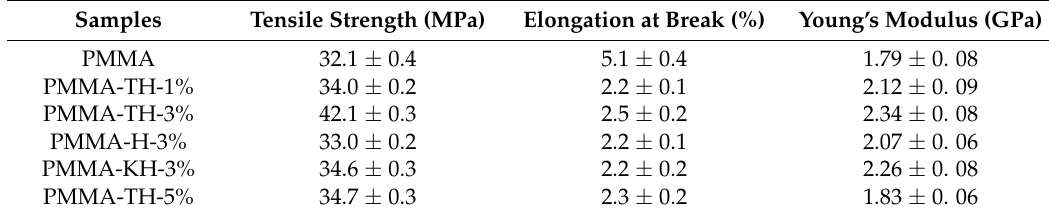
Table 3. The mechanical properties of PMMA/reactive halloysite nanocomposite films.